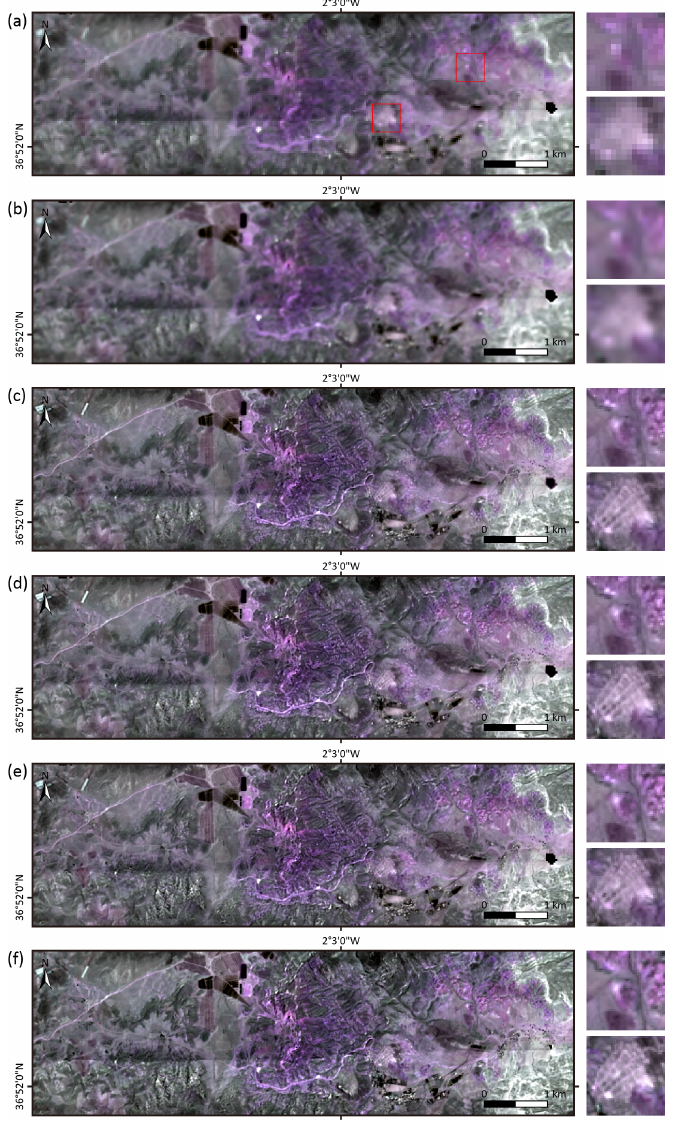
Figure 3. Color composite images (R: 2259 nm, G: 2201 nm, B: 2044 nm) obtained by ( a ) nearest-neighbor interpolation; and ( b ) bicubic interpolation of EnMAP data, and fusion of EnMAP and Sentinel-2 data using ( c ) GSA; ( d ) MTF-GLP; ( e ) CNMF; and ( f ) reference data. Shades of pink indicate the presence